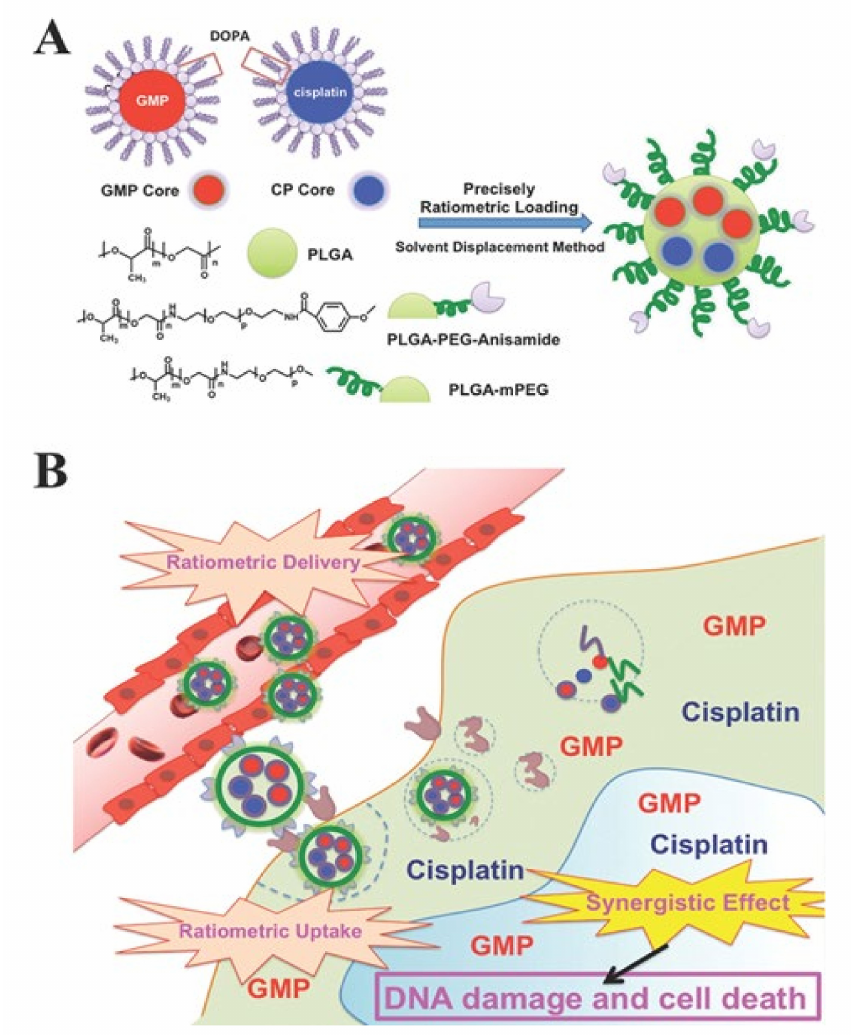
Figure 4. ( A )SchematicdiagramofPLGA-PEG-AnisamideNP(PLGANP)includingadioleoyl phosphatidic acid (DOPA)-coated cisplatin core (CP core) and DOPA-coated gemcitabine monophosphate core (GMP core) through solvent substitution method. ( B ) Ratiometric drug delivery of CP core and GMP core co-loaded PLGA nanoparticles (combination NP) into cancer cells. Reproduced with permission from [30], Advanced Functional Materials,